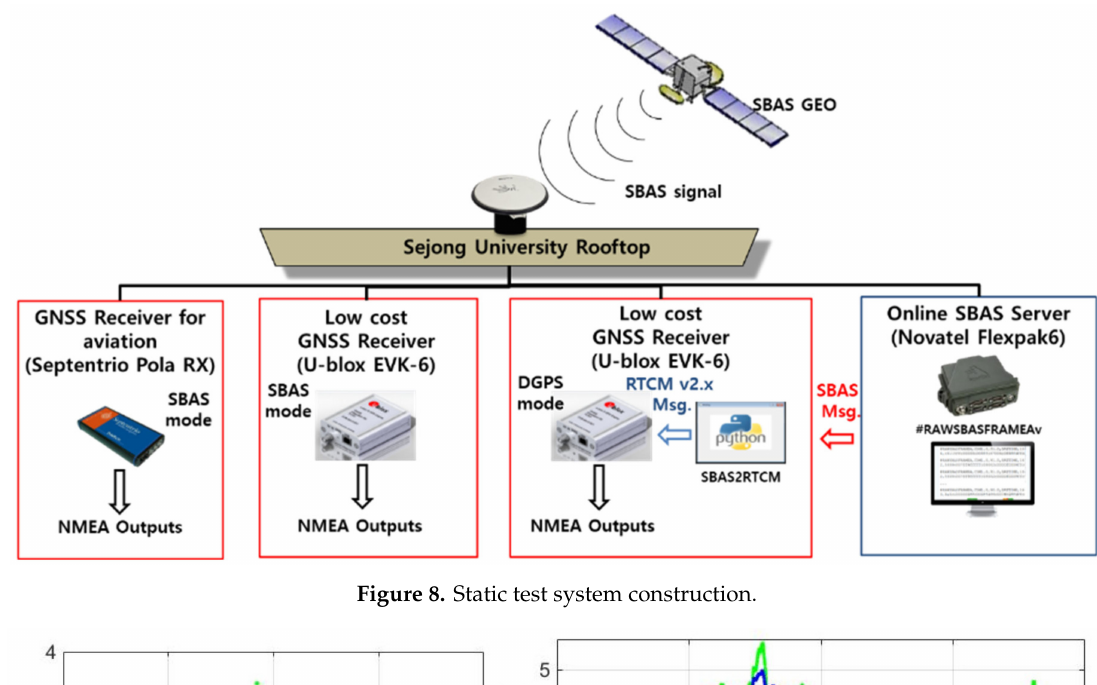
Figure 8. Static test system construction.